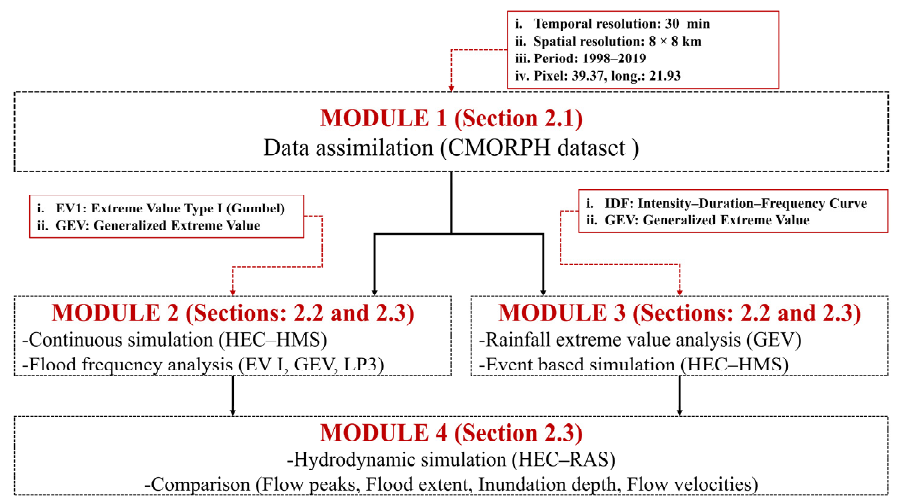
Figure 1. Proposed methodological approach.